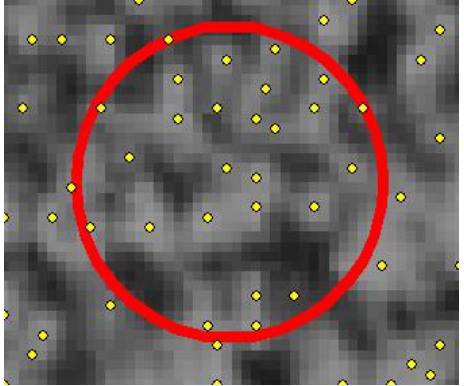
Figure 6. Local maxima detected from the implementation of the automatic procedure on the green band, superimposed on the same band (plot ID 9, Calabrian pine).